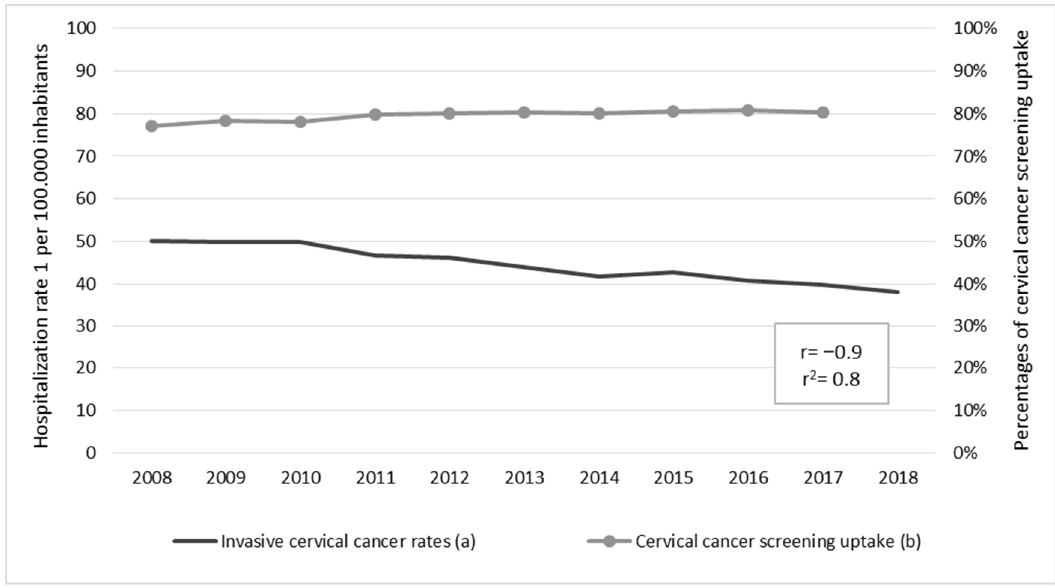
Figure 4. Correlation between hospitalization rates due to invasive cervical cancer and cervical cancer screening uptake with their respective average annual percent change (AAPC): ( a ) 2008–2018 AAPC = −2.8%, 95% CI = −3.2, −2.4, p < 0.001; ( b ) 2008–2018 AAPC = 0.5%, 95% CI = 0.2, 0.7, p < 0.001.